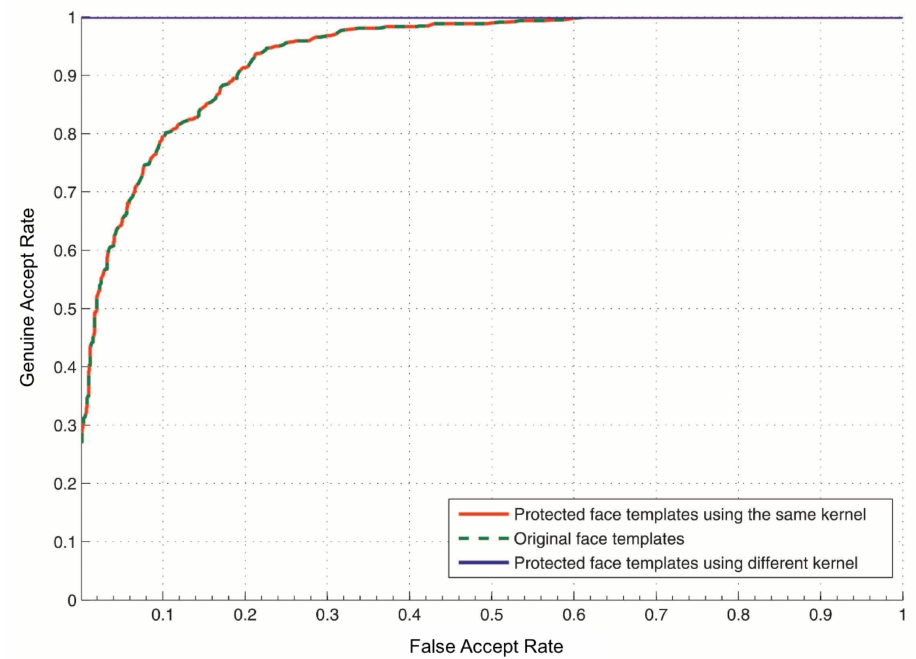
Figure 6. The ROC curve of the unimodal face system in the case of